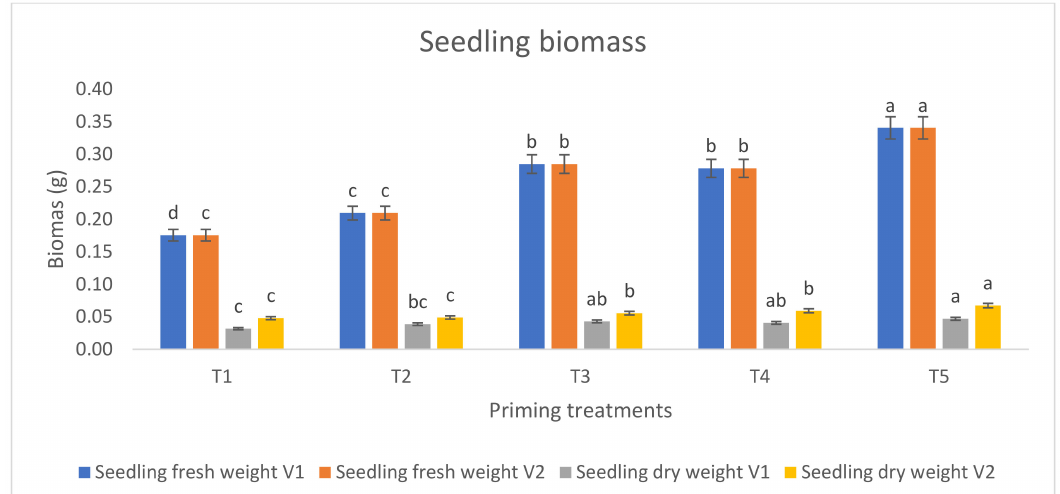
Figure 2. Seedling fresh weight (g) and seedling dry weight (g) of wheat varieties under different priming treatments. The full description of abbreviations T1, T2, T3, T4, T5, V1 and V2 are represented in material and methods section. Lowercase alphabetical letters (a,b,c) represents the significant differences between the different seed priming treatments (Tukey test; p <